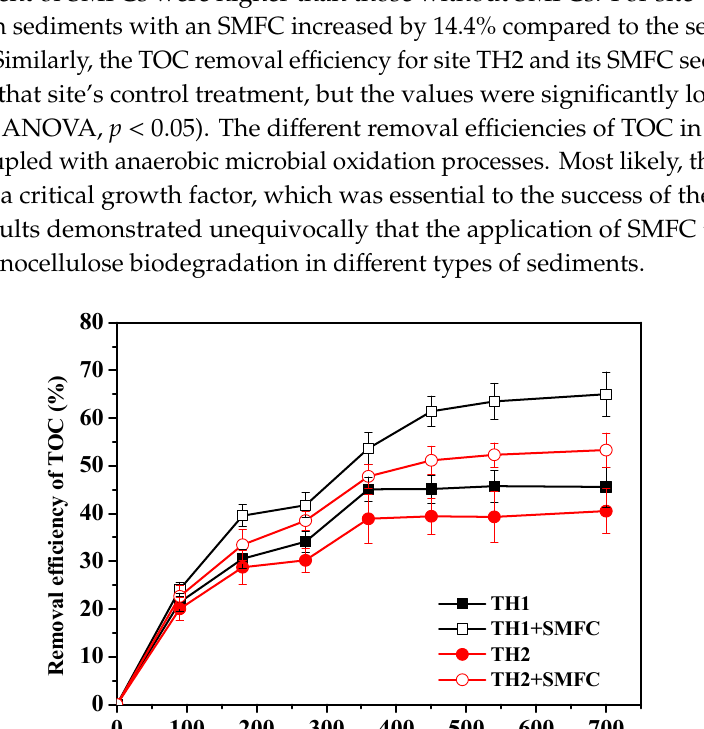
Figure 2. Polarization and power curves for SMFCs produced with TH1 and TH2 sediments on Day 450. Error bars were represented as mean values (n = 2).